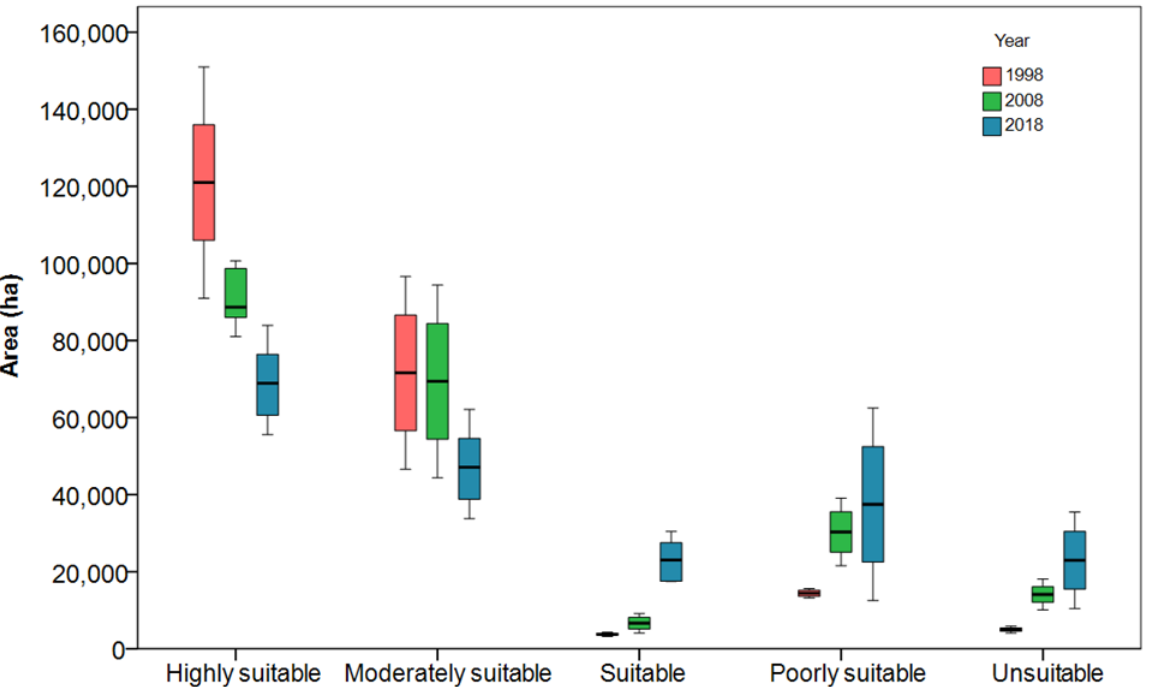
Figure 2. Changes in area size of different habitat suitability classes in the Wami Mbiki Saadani wildlife corridor, Tanzania, for 1998, 2008, and 2018, based on Analytical Hierarchy Process (AHP) calculations [58,59]. Suitability was assessed by using the spatial analyst tool in Arc Map (10.8). The horizontal line represents median, standard error of the mean (box), and 95% confidence interval of the mean (whiskers).